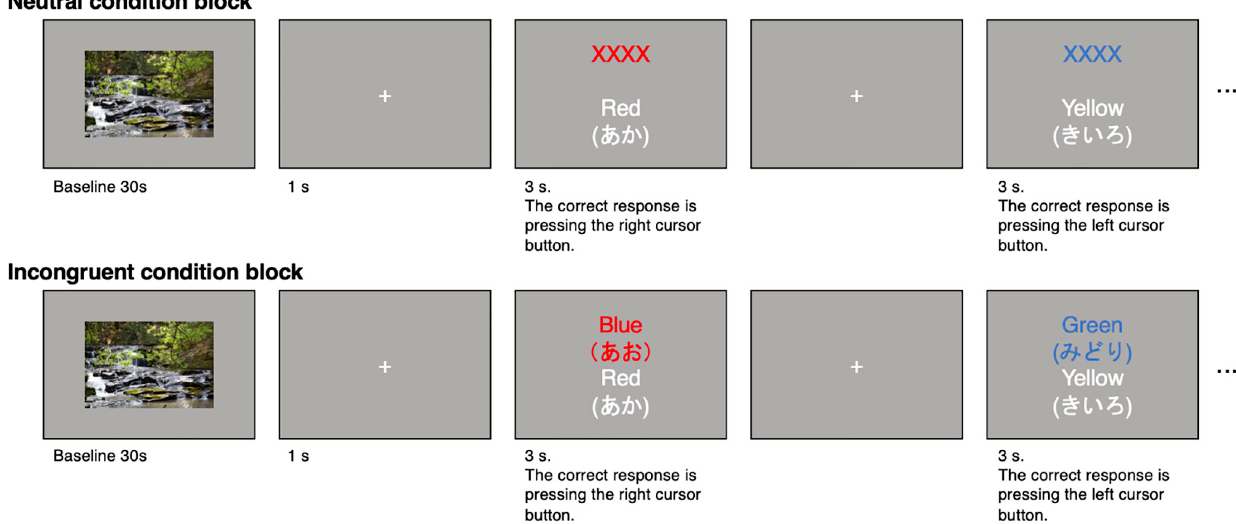
Fig 1. Scheme of the color-word Stroop task. The scheme consists of two blocks the neutral condition block and the incongruent condition block. The order of the two blocks was randomized.